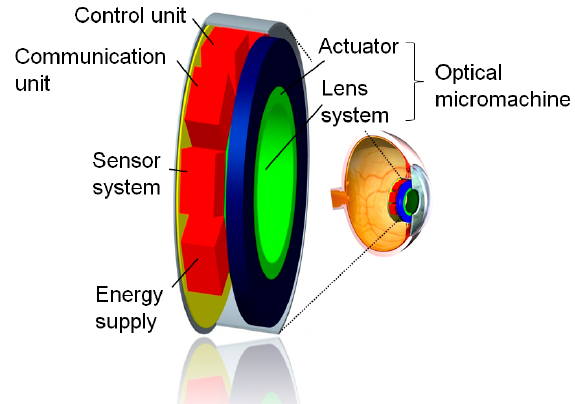
Figure 1. Schematic representation of the AAS and its position within the capsular bag of the human eye (inset on the right).